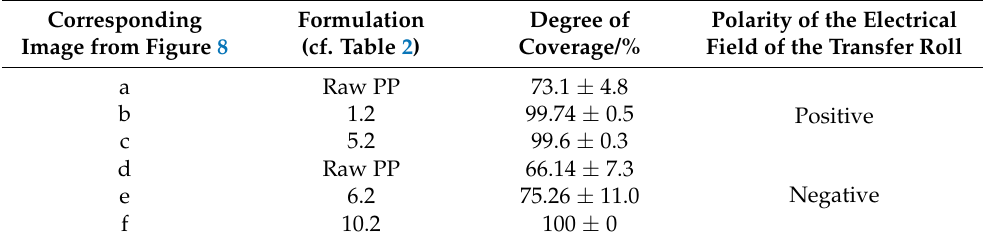
Table 4. Measured values of the degree of coverage on the transfer